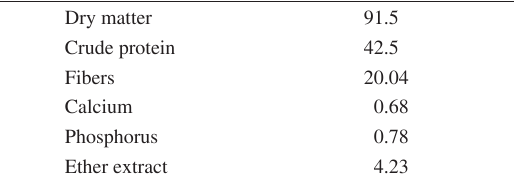
Figure 1. Simplex-lattice design